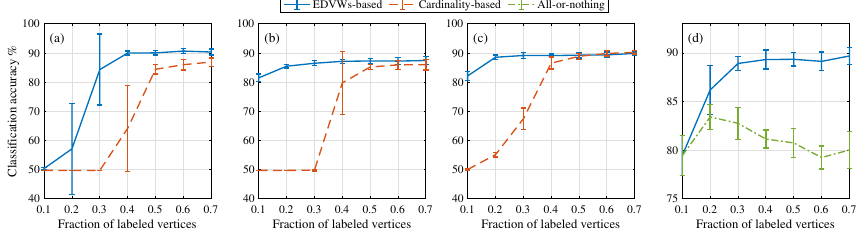
Fig. 4 Performance comparison between the proposed splitting functions and existing ones. ( a ), ( b ) and ( c - d ) respectively correspond to the splitting functions w e ( S ) = γ e ( S ) · γ e ( e \ S ) , w e ( S ) = min { γ e ( S ) , γ e ( e \ S ) } and w e ( S ) = min { γ e ( S ) , γ e ( e \ S ) , βγ e ( e ) } . We fix β = 0.15 in ( c ) and fix α = 1 in ( d ). The red curves (cardinality-based) and the green curve (all-or-nothing) respectively